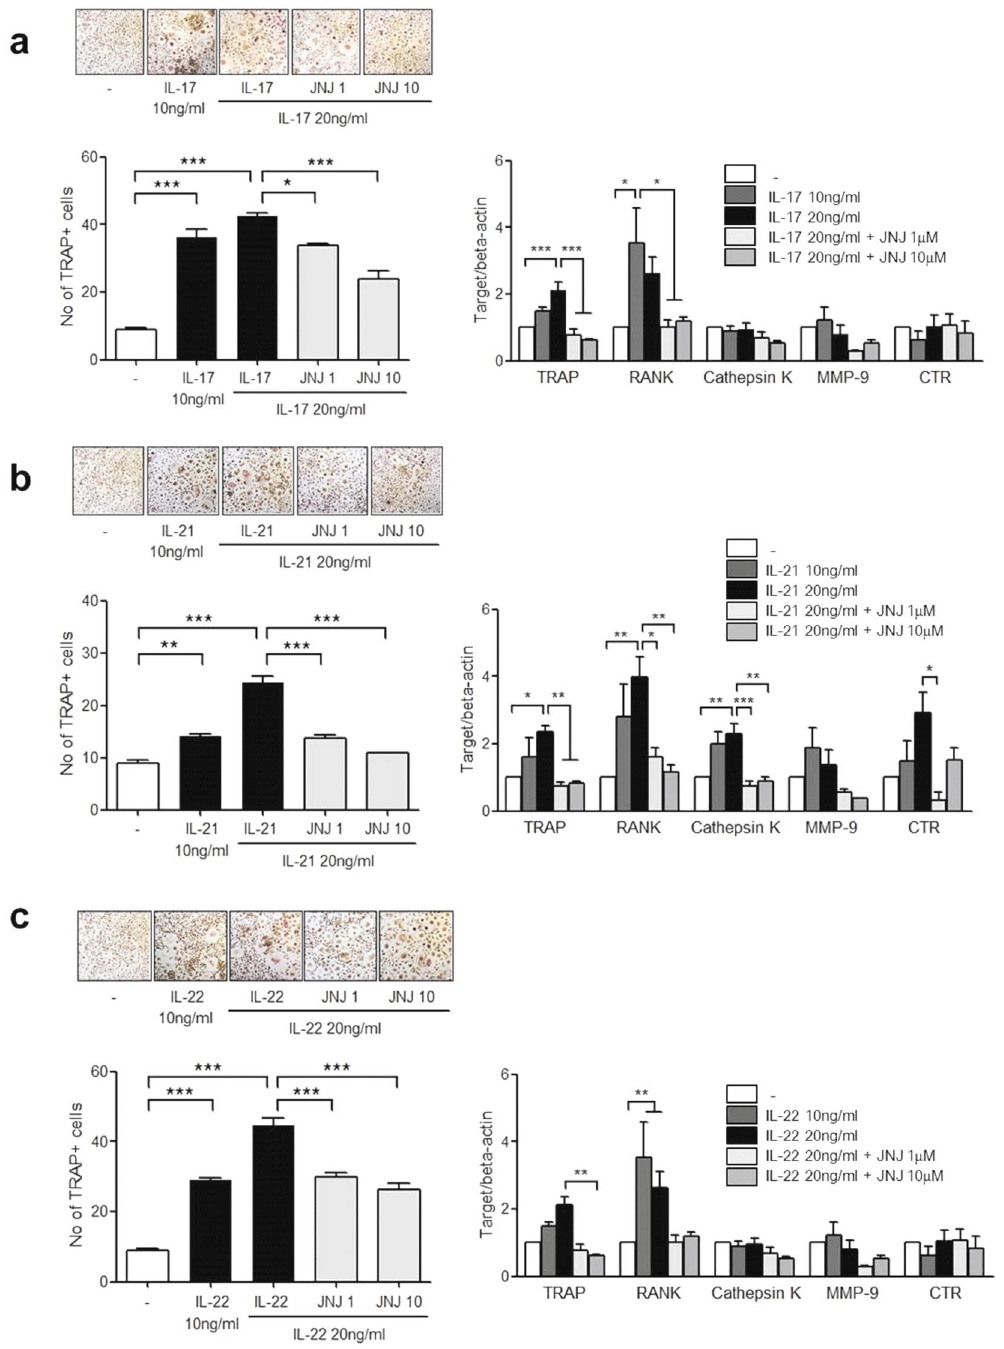
Figure 6. Th17 cytokine-induced osteoclast differentiation in monocytes and the effect of H4R antagonist. ( a ) PB monocytes isolated were cultured with 10–20 ng/ml of IL-17 and 1–10 μ M of JNJ7777120 in the presence of 25 ng/ml of M-CSF. After 21 days of culturing, TRAP-positive multinucleated cells were counted and the mRNA expression of osteoclast markers such as TRAP, RANK, cathepsin K, MMP-9 and CTR was determined using real-time PCR. ( b ) PB monocytes were cultured with 10–20 ng/ml of IL-21 and 1–10 μ M of JNJ7777120 in the presence of 25 ng/ml of M-CSF. After 21 days of culturing, TRAP-positive multinucleated cells were counted and the mRNA expression of osteoclast markers such as TRAP, RANK, cathepsin K, MMP-9 and CTR was determined using real-time PCR. ( c ) PB monocytes were cultured with 10–20 ng/ml of IL-22 and 1–10 μ M of JNJ7777120 in the presence of 25 ng/ml of M-CSF. After 21 days of culturing, TRAP-positive multinucleated cells were counted and the mRNA expression of osteoclast markers such as TRAP, RANK, cathepsin K, MMP-9 and CTR was determined using real-time PCR. The figures represent one of three independent experiments. The data represent the mean ± SEM of three independent experiments. * P < 0.05, ** P < 0.01 and *** P < 0.001. TRAP; tartrate-resistant acid phosphatase, JNJ; JNJ7777120, RANK; receptor activator of nuclear factor- κ B, MMP-9; matrix metalloproteinase-9, CTR; calcitonin